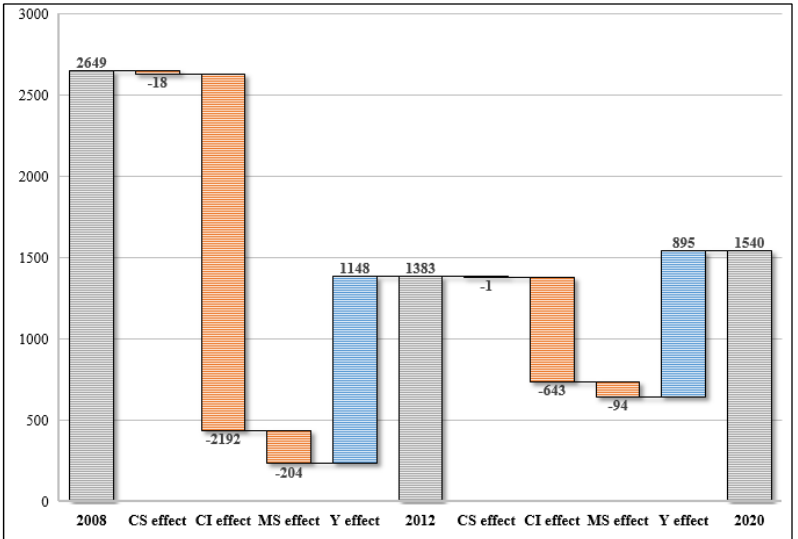
Figure 4. Decomposition results of various driving forces to CO 2 emissions changes in Shenzhen’s manufacturing.